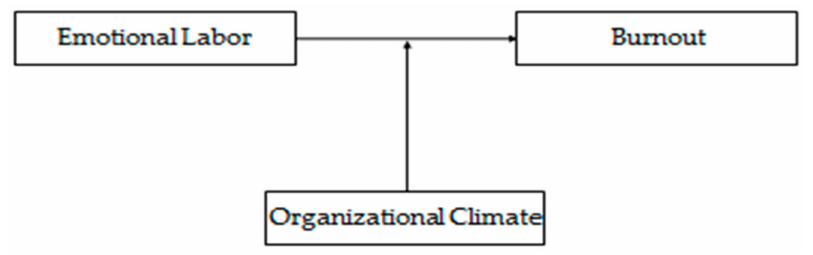
Figure 1. Research hypothesis of this